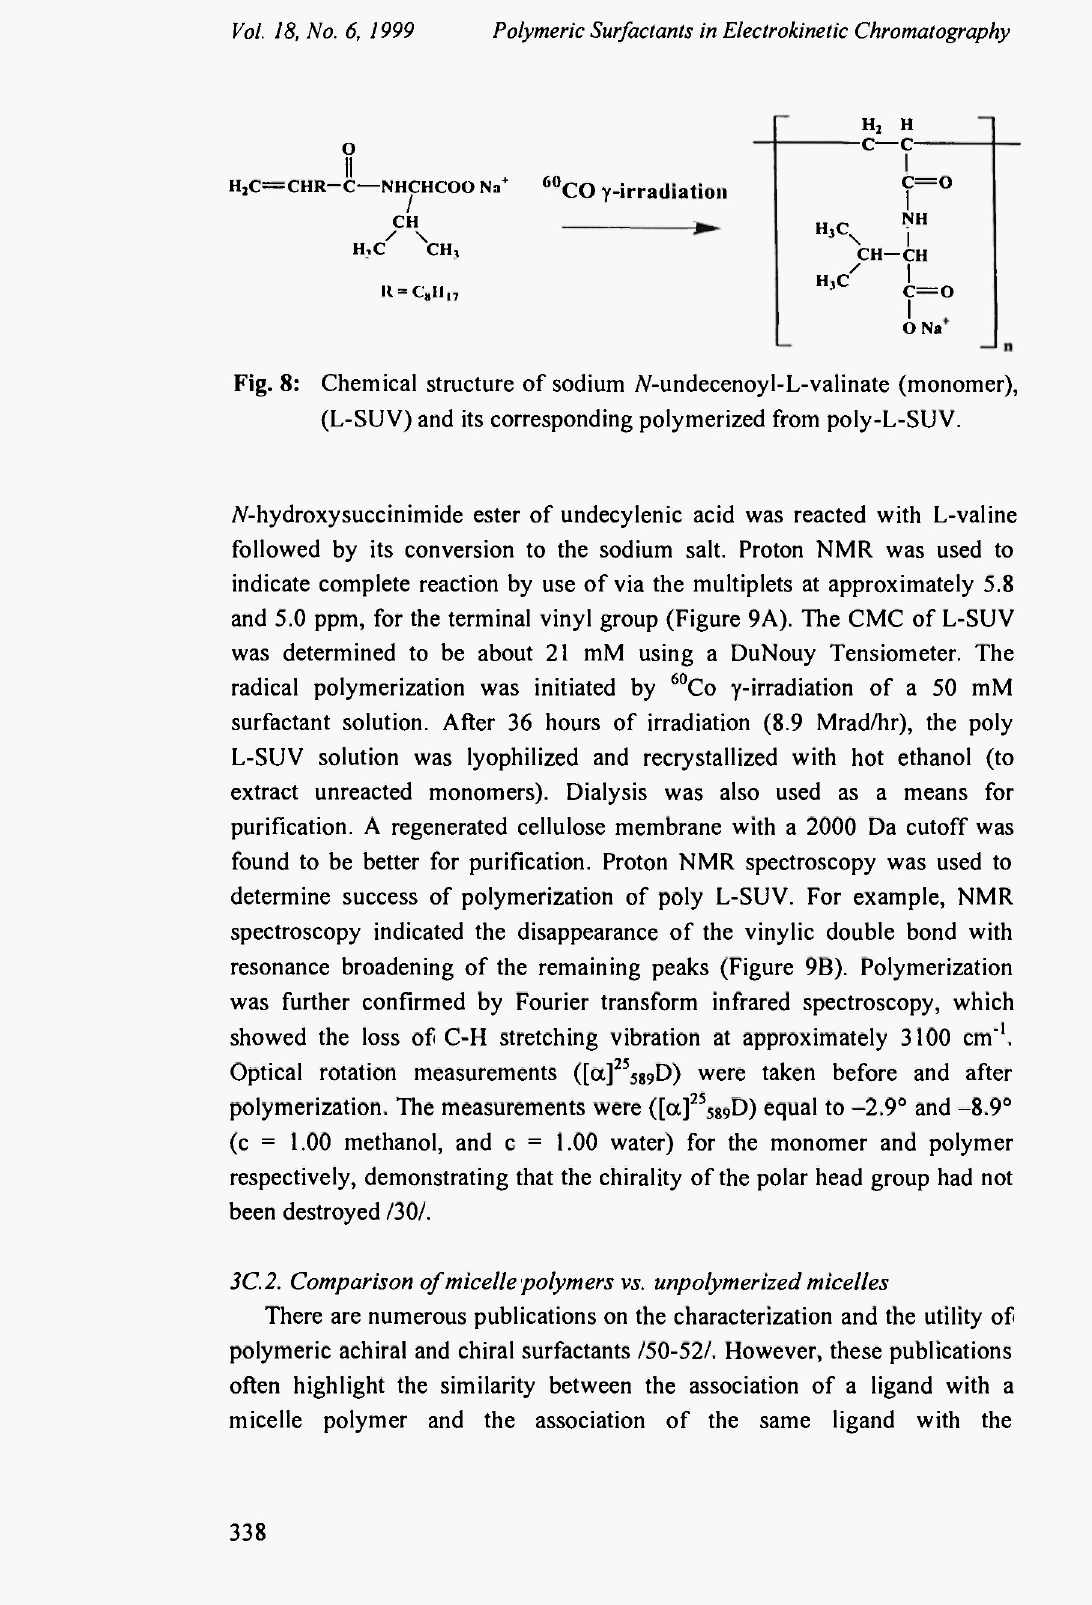
Fig. 8: Chemical structure of sodium 7V-undecenoyl-L-valinate (monomer), (L-SUV) and its corresponding polymerized from